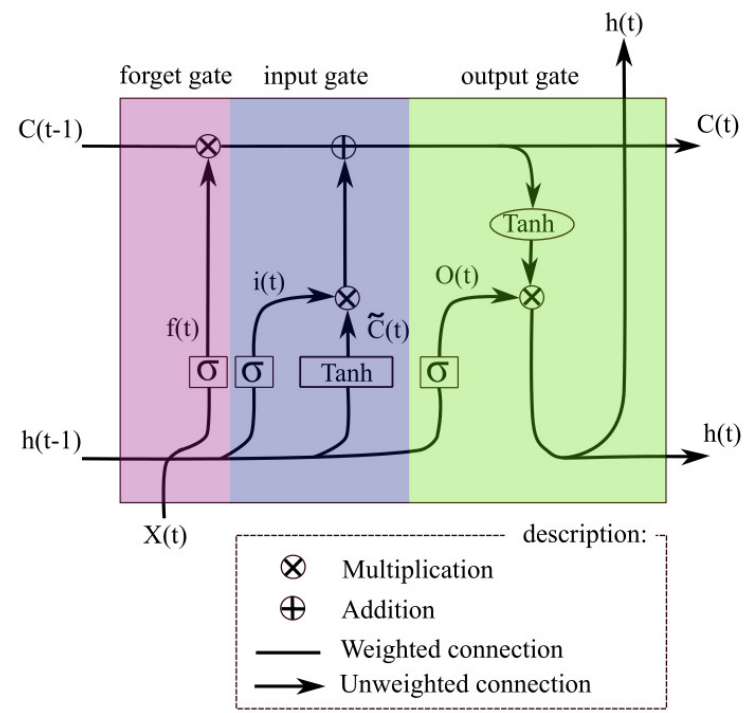
Figure 1. The LSTM unit